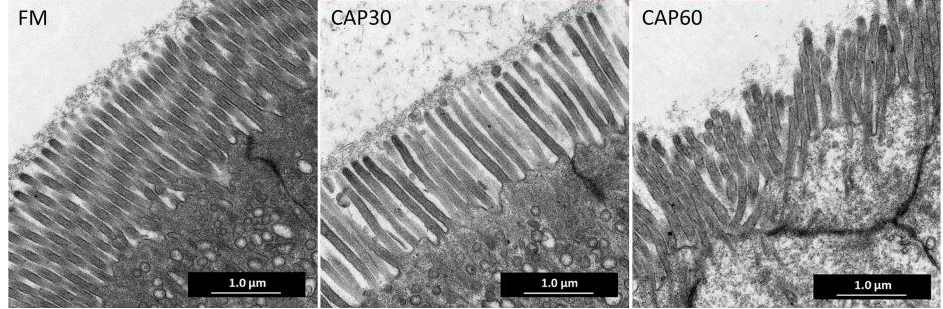
Table 8. Distal intestinal morphological histology of pearl gentian grouper fed gradient substitution of fishmeal in the diet with CAP (TEM).